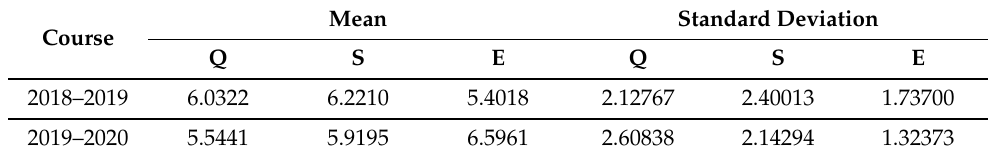
Table 5. Mean and Standard Deviation for questionnaires (Q), Software (S) and Exams (E). Mean Standard Deviation Course Q S